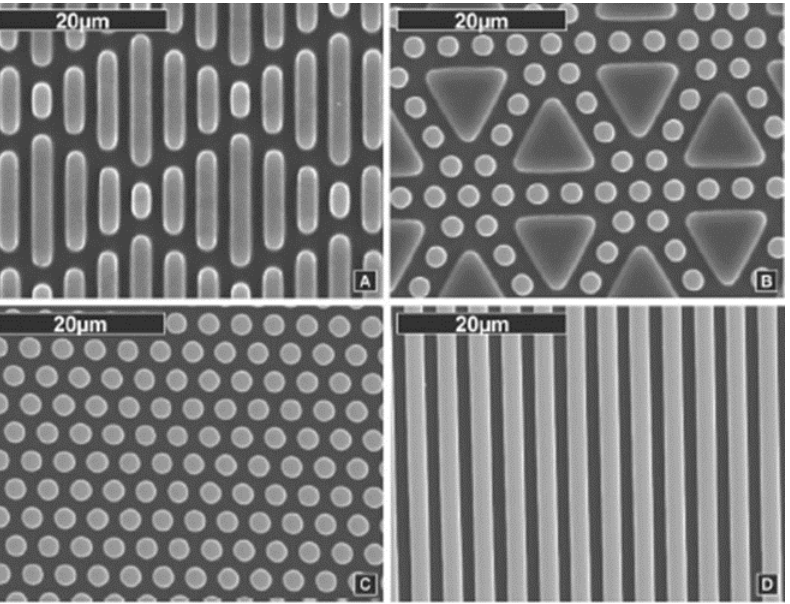
Figure 1. Scanning electron micrographs (SEM) of engineered topographies on a polydimethylsiloxane surface: ( A ) Two-mm ribs of lengths 4 mm, 8 mm, 12 mm, and 16 mm are combined to create a sharklet adhesively backed film, ERI = 9.5; ( B ) 10-mm equilateral triangles combined with 2-mm-diameter circular pillars, ERI = 8.7; ( C ) hexagonally packed 2-mm-diameter circular pillars, ERI = 5.0; and ( D ) 2-mm-wide ridges separated by 2-mm-wide channels, ERI = 6.1. [8]